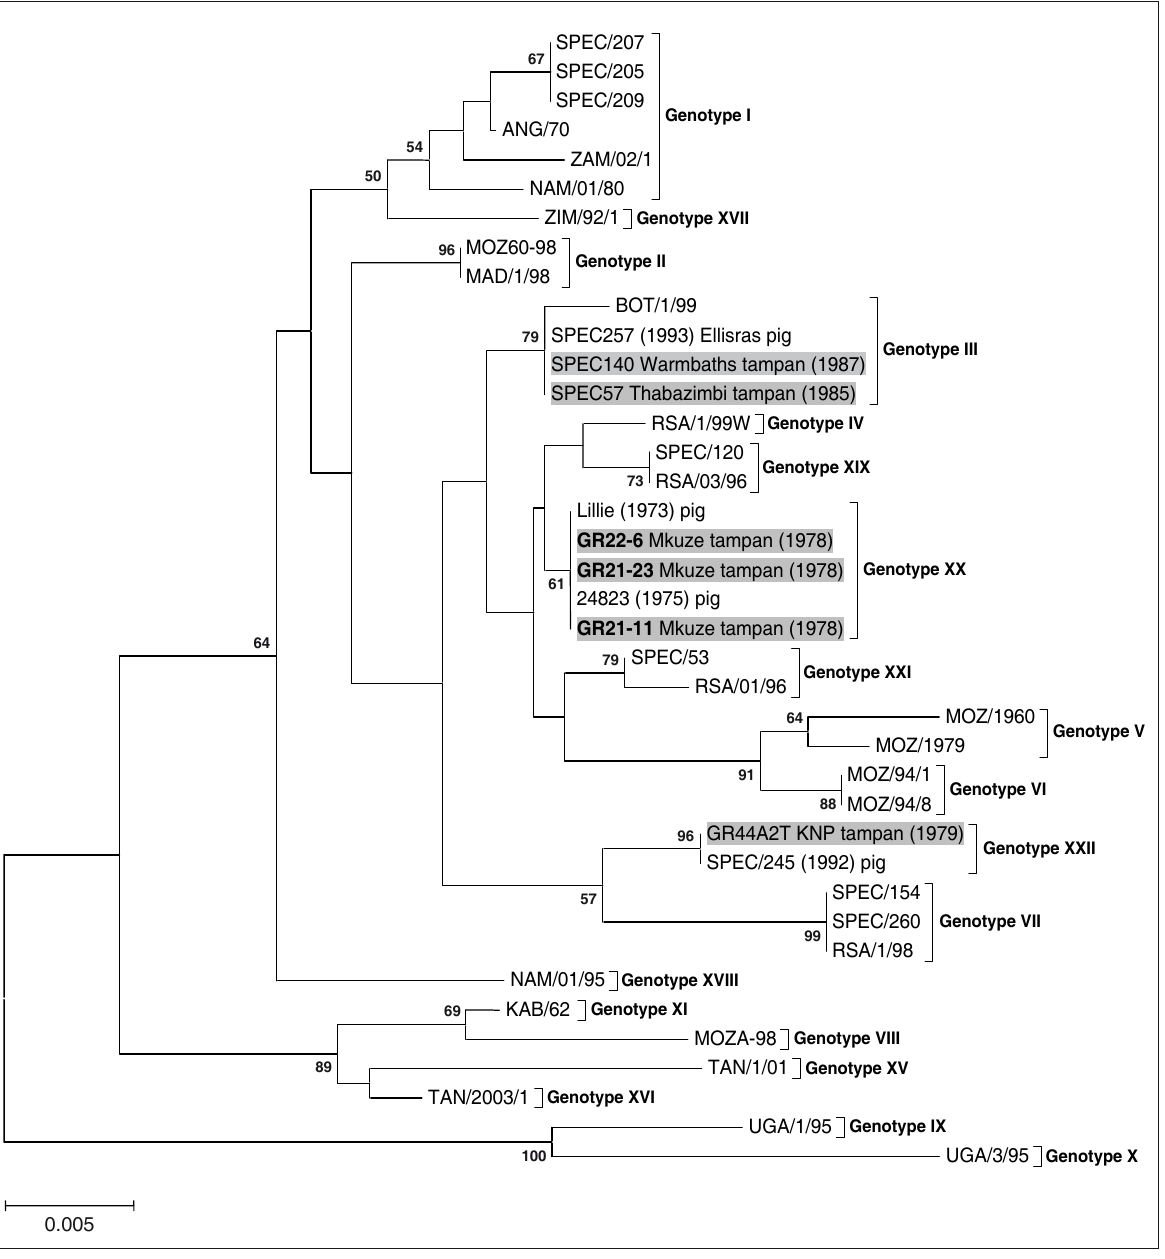
FIG. 2 Genetic relatedness of the three Mkuze Game reserve tampan viruses isolated in 1978 (indicated in bold with grey shading) and three additional South African tampan viruses (denoted by grey shading alone), based on C­terminal p72 gene sequence